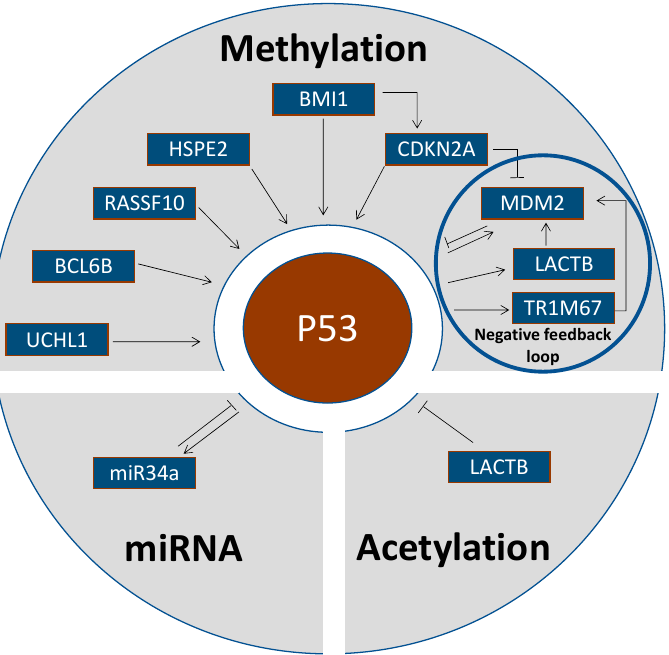
Figure 1. Epigenetics alterations upstream of p53.